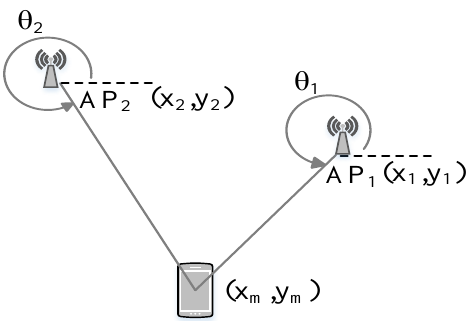
Figure 10. Triangulation localization using two known APs and AOA.